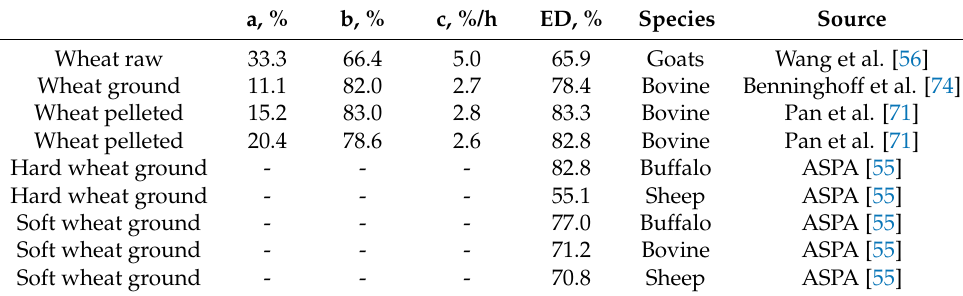
Table 5. Protein degradability of raw and treated wheat